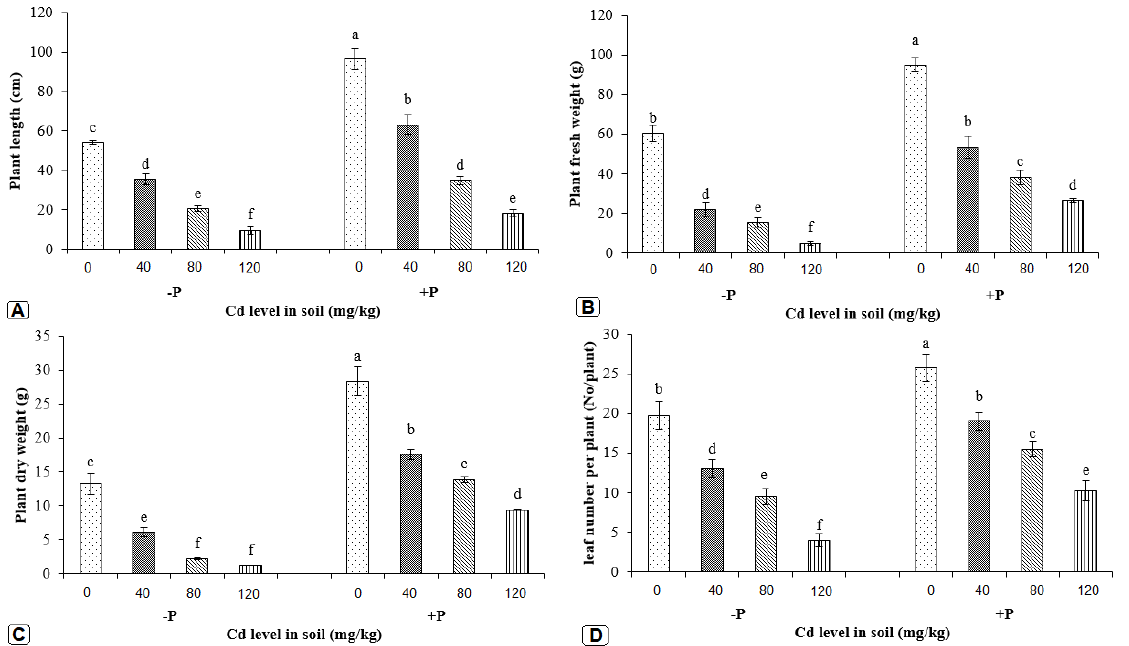
Fig. 2. The effect of P. indica on A) plant length; B) plant fresh weight; C) plant dry weight and D) leaf number per plant under different Cd concentrations in sunflower. P: P. indica. Values are mean ± SD; n = 5. The same letter within each column indicates no significant difference among treatments using Duncan’s Multiple Range Test at P < 0.05.